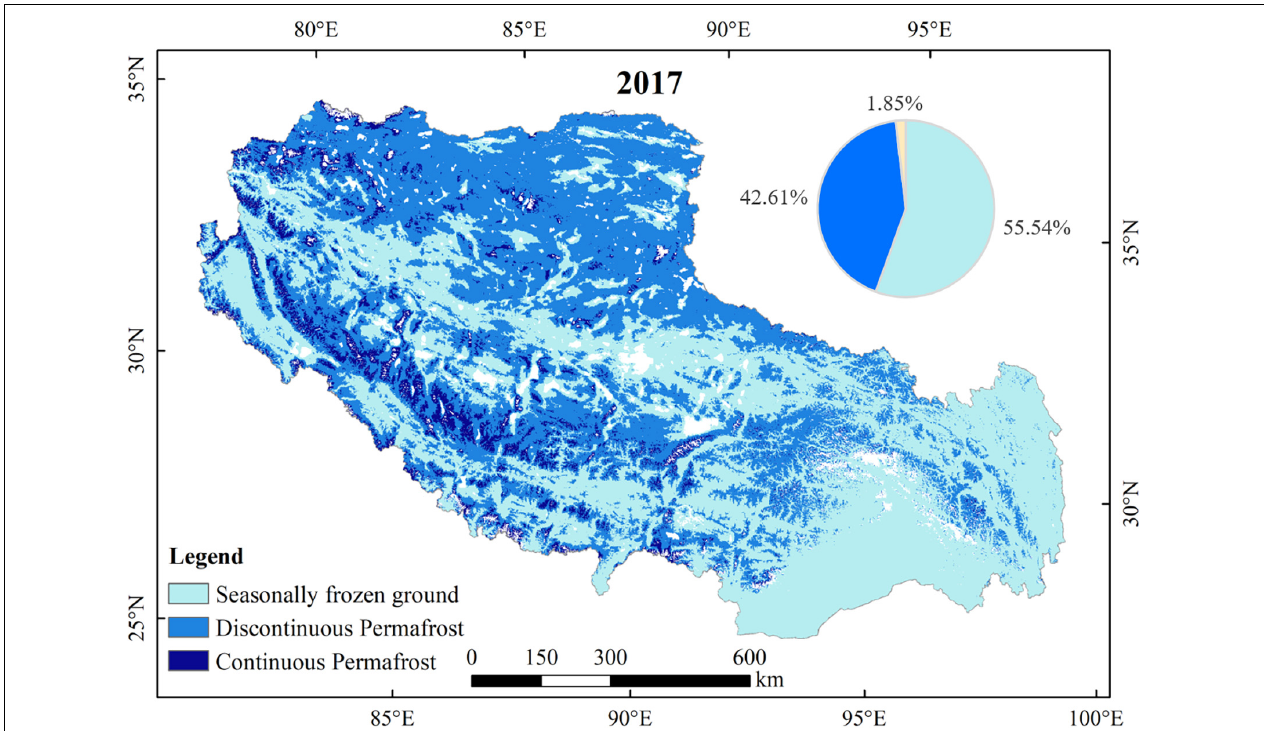
FIGURE 7 | The published permafrost map across Tibet derived from National Tibetan Plateau Data Center (NTPDC) (htTibet://data.Tibetdc.ac.cn). Note that the white area is undefined.